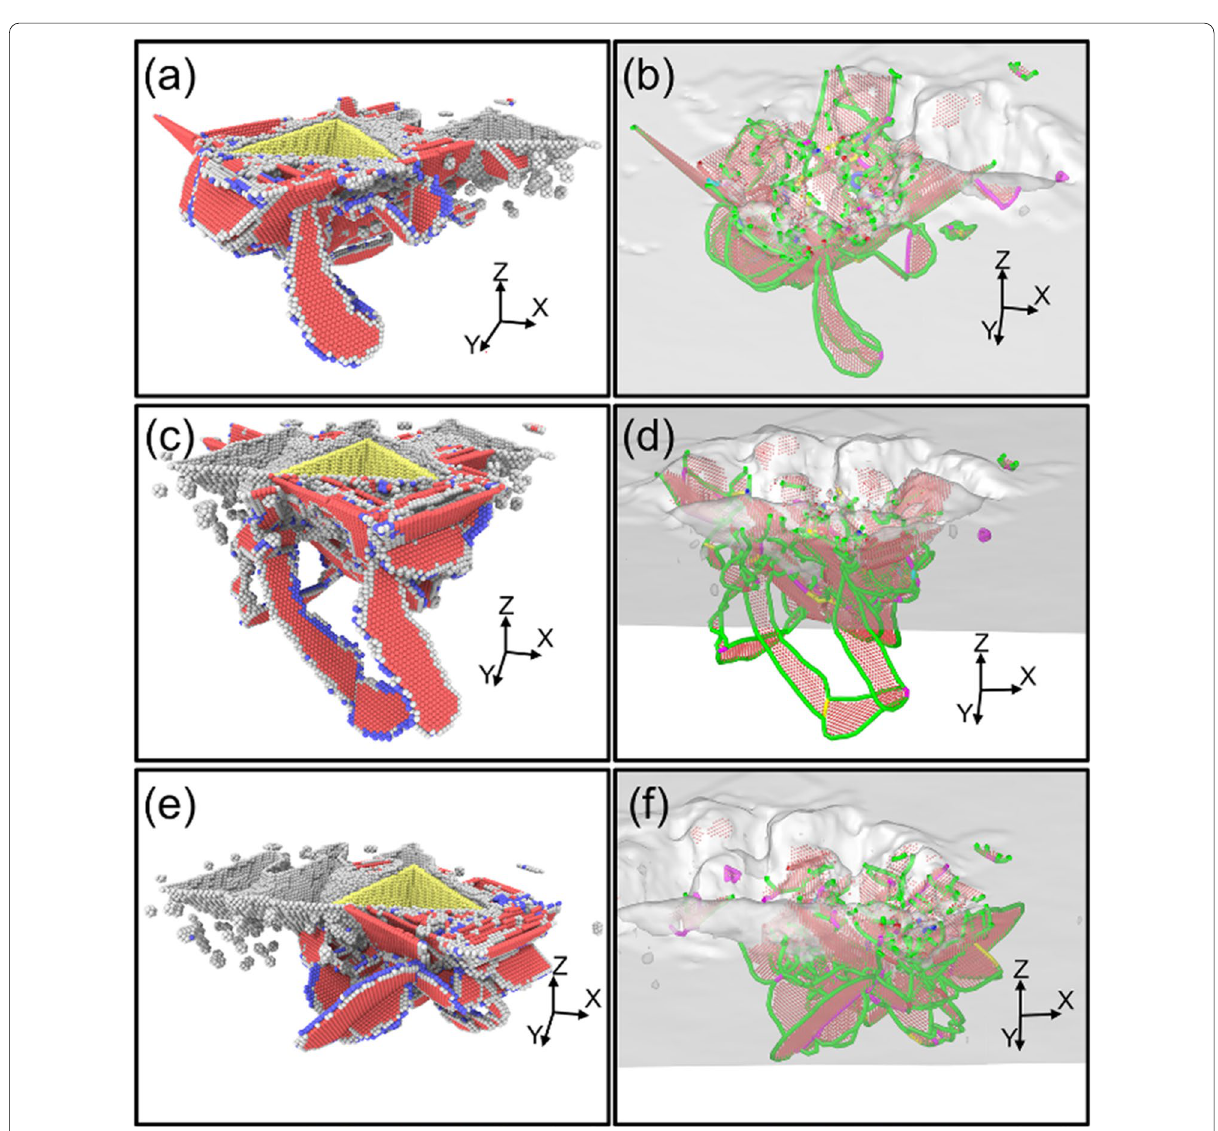
Fig. 6 Dislocation structures generated in Single-Indenter indentation process with the spacing of 5 nm a CNA snapshot in the fourth indentation, b DXA snapshot in the fourth indentation, c CNA snapshot in the fifth indentation, d DXA snapshot in the fifth indentation, e CNA snapshot in the sixth indentation, f DXA snapshot in the sixth